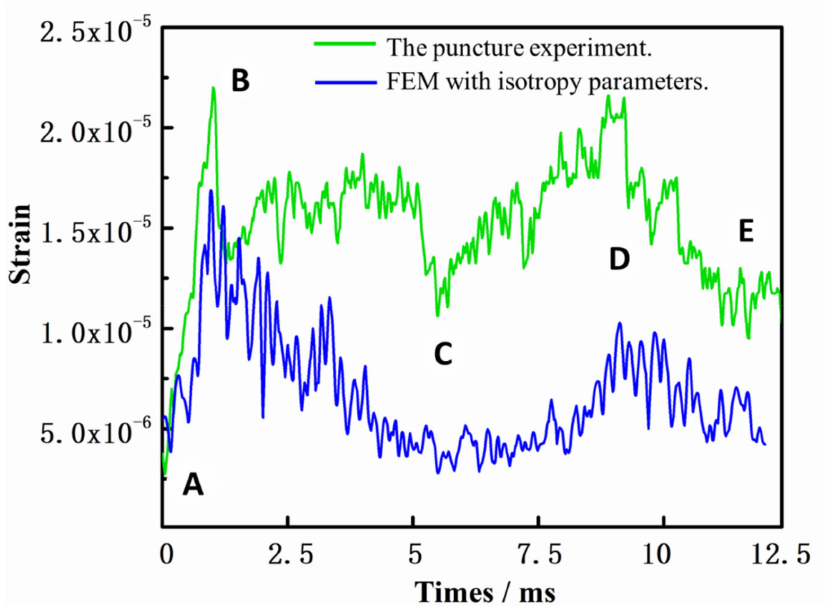
Figure 13. Strain results obtained using the finite element method (FEM) with isotropy parameters. (The curves marked A to E in the figure represent different stages in the puncture